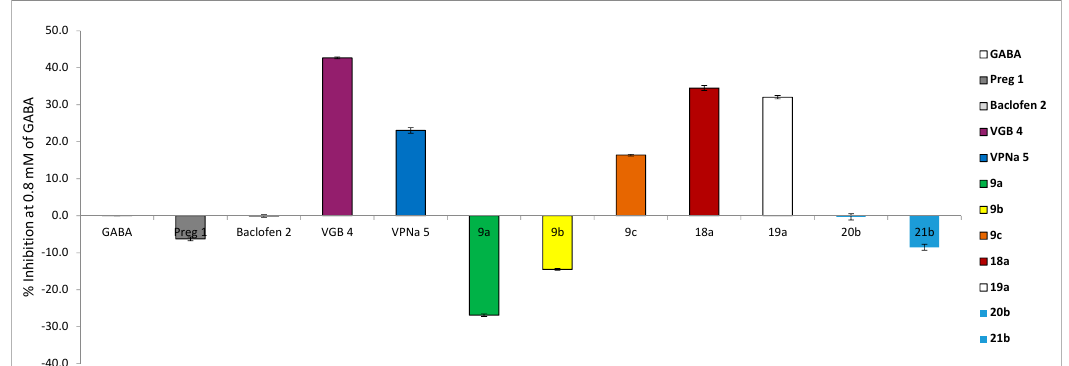
Figure 4. GABA-AT % inhibition of compounds 9a – c and 18 – 21 as compared to VGB 4 and VPNa 5 . * p < 0.05: Significant difference comparing GABA with 9a – c and 18 , 19 . * p < 0.05: Significant difference comparing VGB 4 with 9a – c and 20 , 21 . * p < 0.05: Significant difference comparing VPNa 5 with 9a – b and 18 , 20 , 21 . Comparisons were made by the one-way ANOVA test and Duncan’s means analysis test.